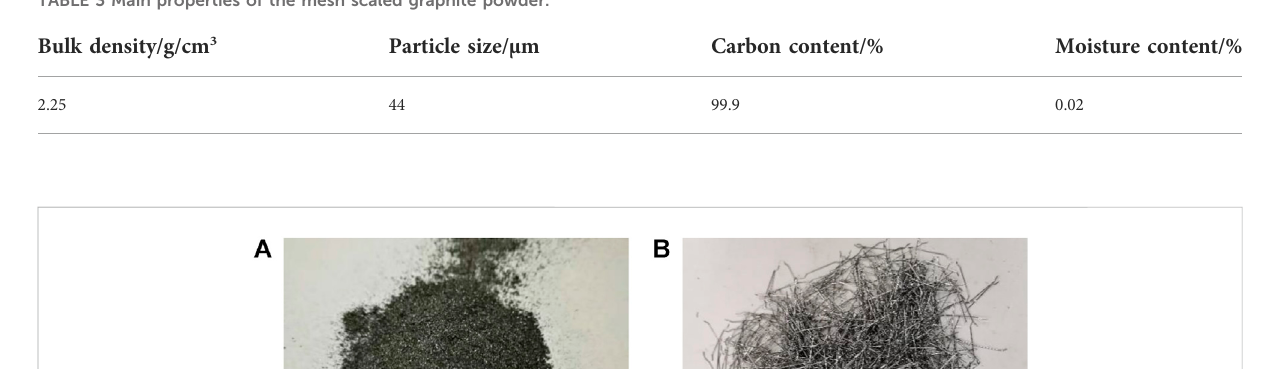
TABLE 3 Main properties of the mesh scaled graphite